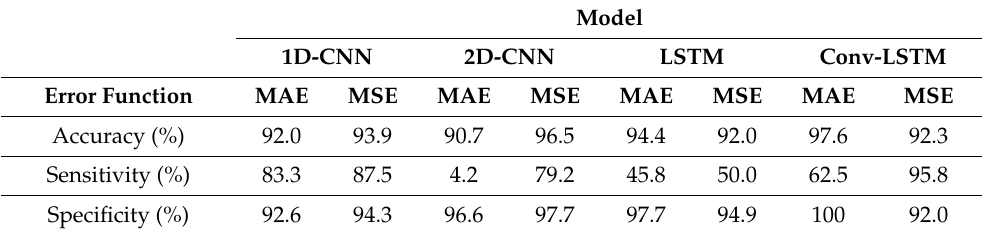
Table 4. Classification